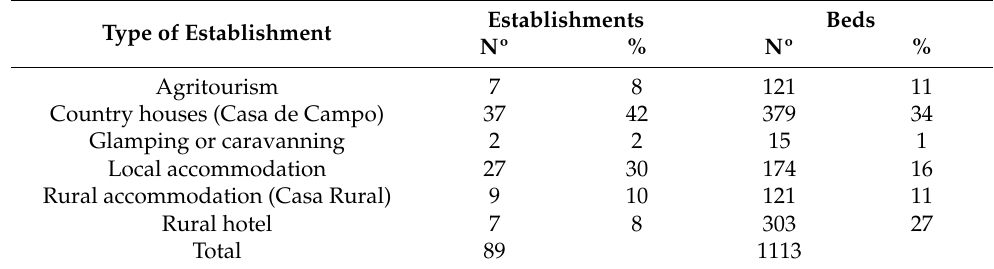
Table 4. Main tourism parameters (2021).